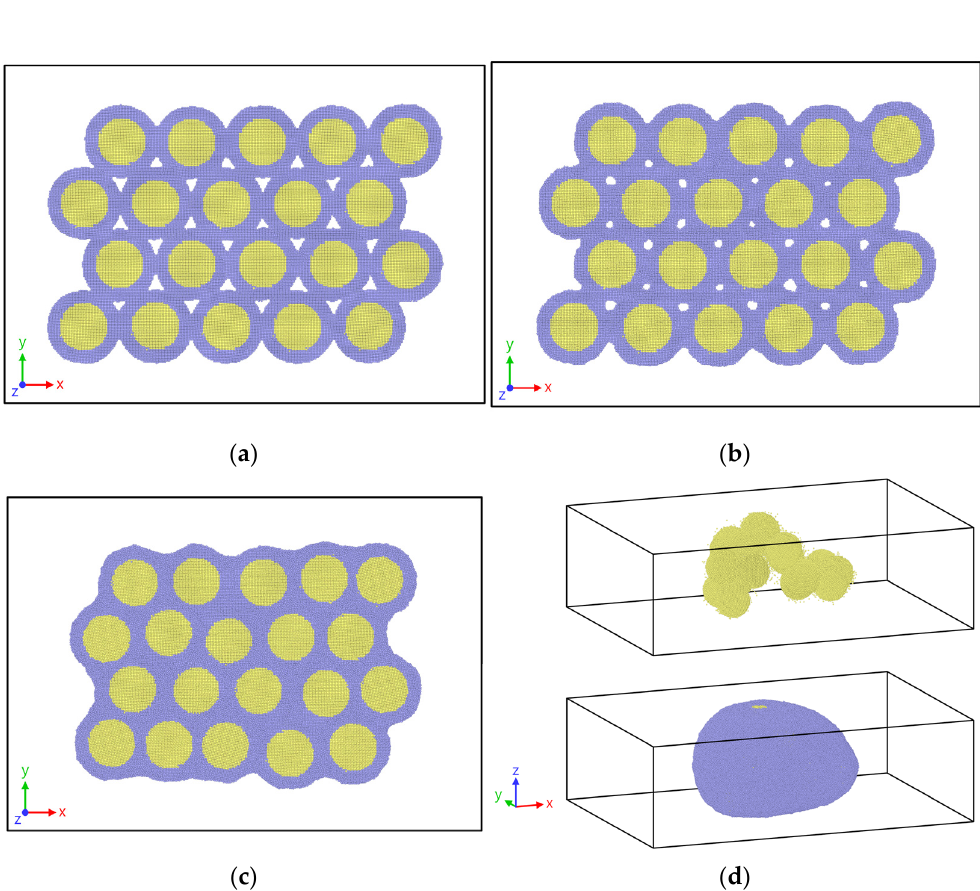
Figure 7. Example cross-sectional view of atomic configurations of the C-type stacked-NPs model with 30% core volume fraction in different instants (temperatures): ( a ) at 298 K, ( b ) at T a , ( c ) at T nv , and ( d ) at a relatively high temperature of 1050 K; panel ( d ) reveals the state of Ti cores in a large liquid oval with a melted Al shell in 3D view. Table 1. Aggregation temperature (T a ) and “no-void” temperature (T nv ) for both types with 3%, 12%, and 30% core volume fraction (CVF) NPs under 0.04, 0.2, 0.5, and 1.0 K ps − 1 heating rate (HR) melt- ing processes.